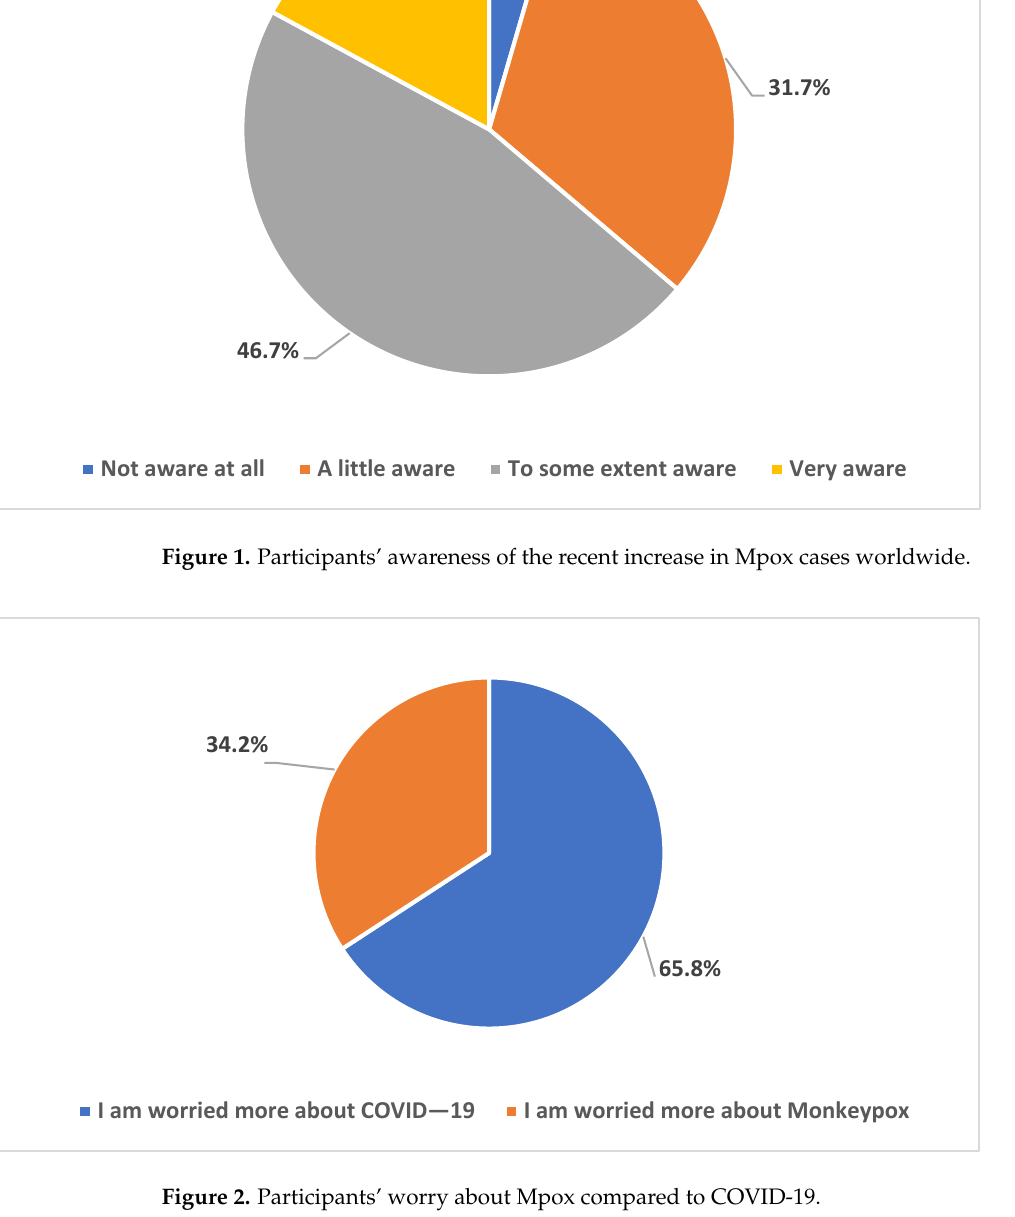
Figure 2. Participants’ worry about Mpox compared to COVID-19.